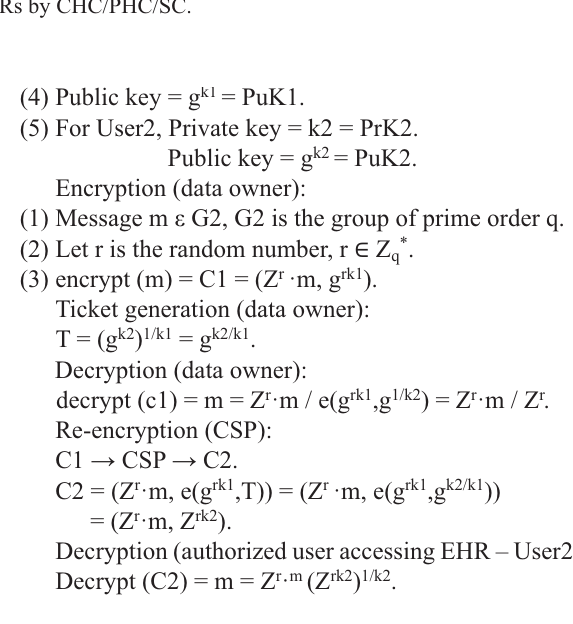
Fig. 3. Storage of EHRs by